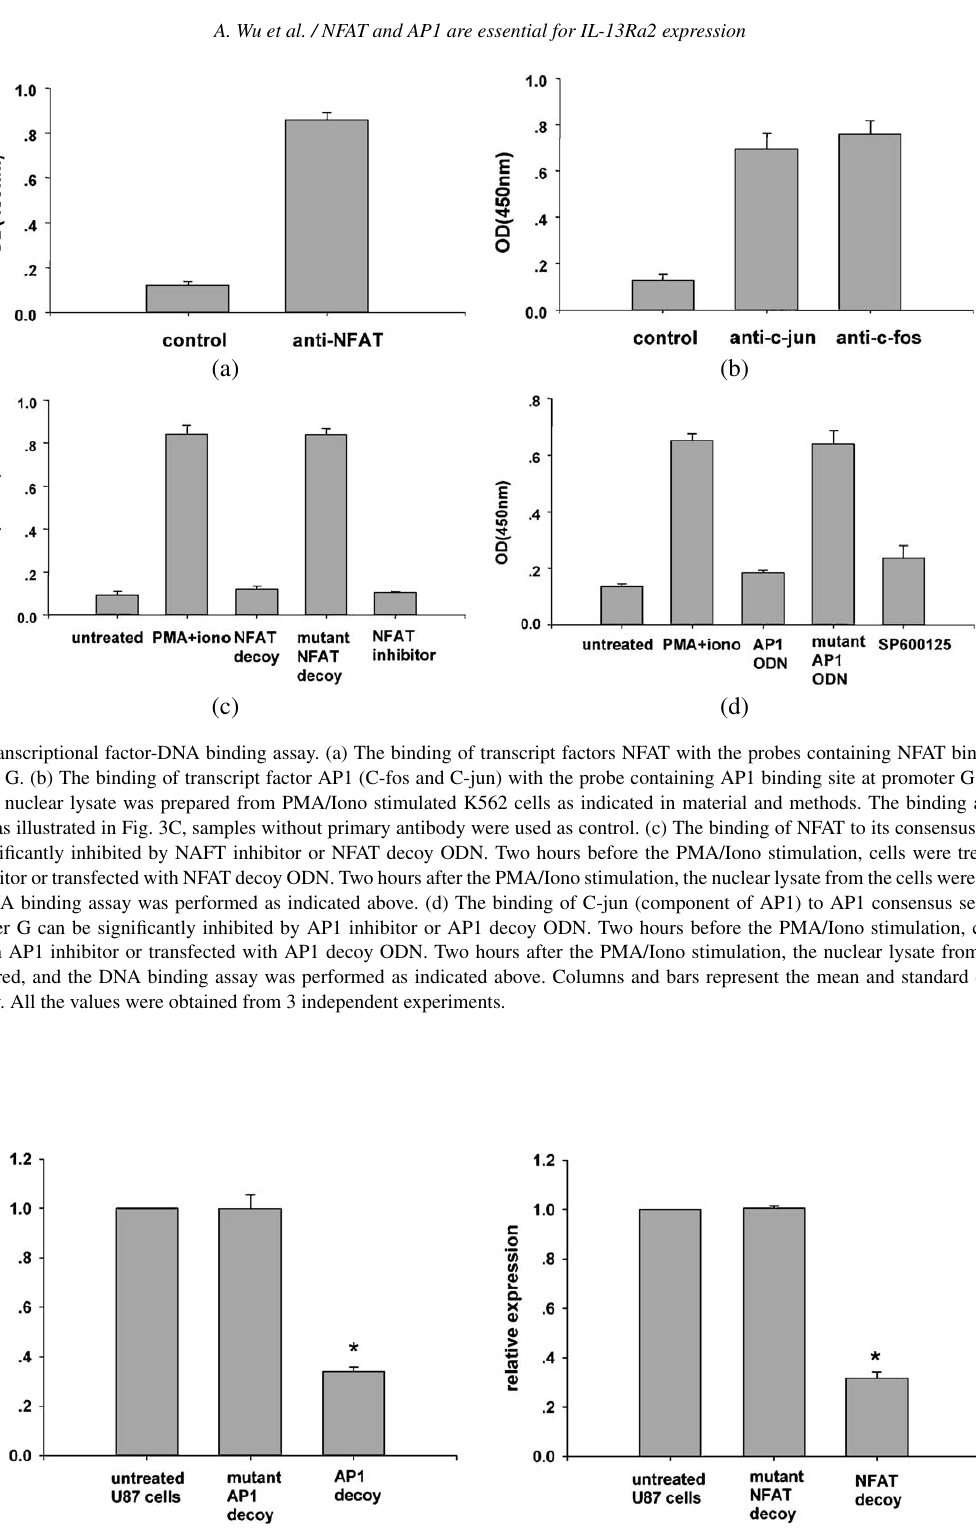
Fig. 4A. The expression of human IL-13Ra2 transcript G in U87 cells can be inhibited with NFAT decoy ODN or AP1 decoy ODN. NFAT mutant ODN or AP1 mutant ODN was used as